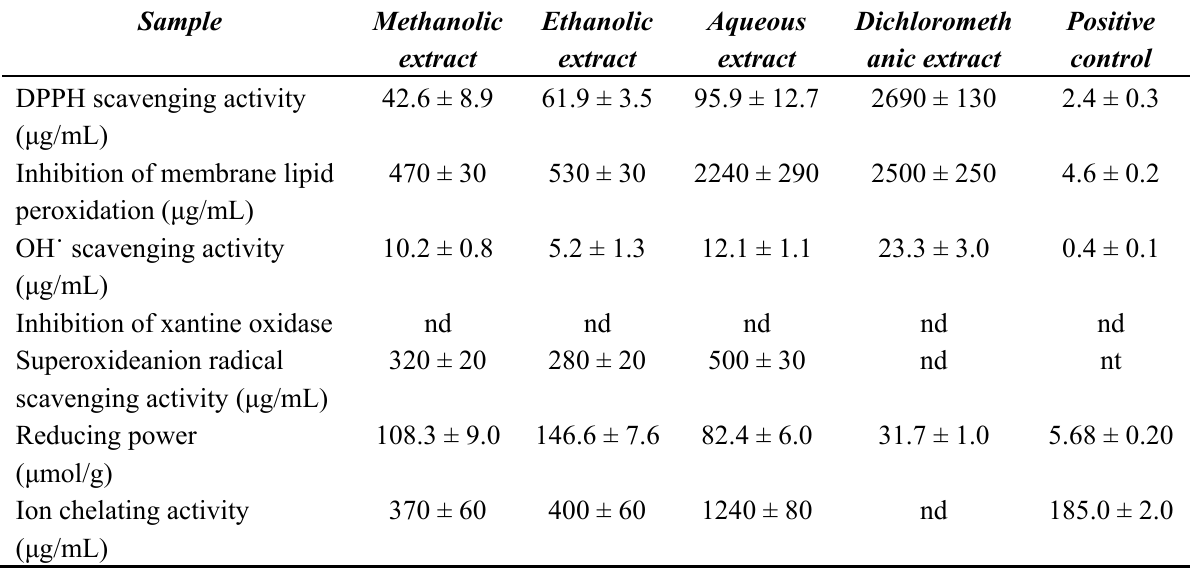
Table 3. Comparative overview of antioxidant activity of C. platycarpos extracts obtained by various